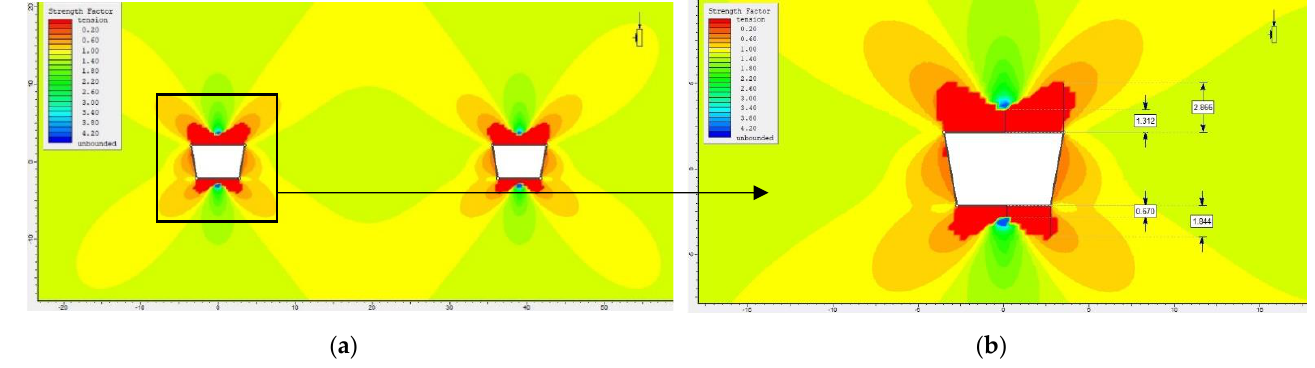
Figure 15. Distribution of strength factor values in the cross-section through ramps drilled in sandstone: ( a ) view of both headings; ( b ) close-up of a single excavation.